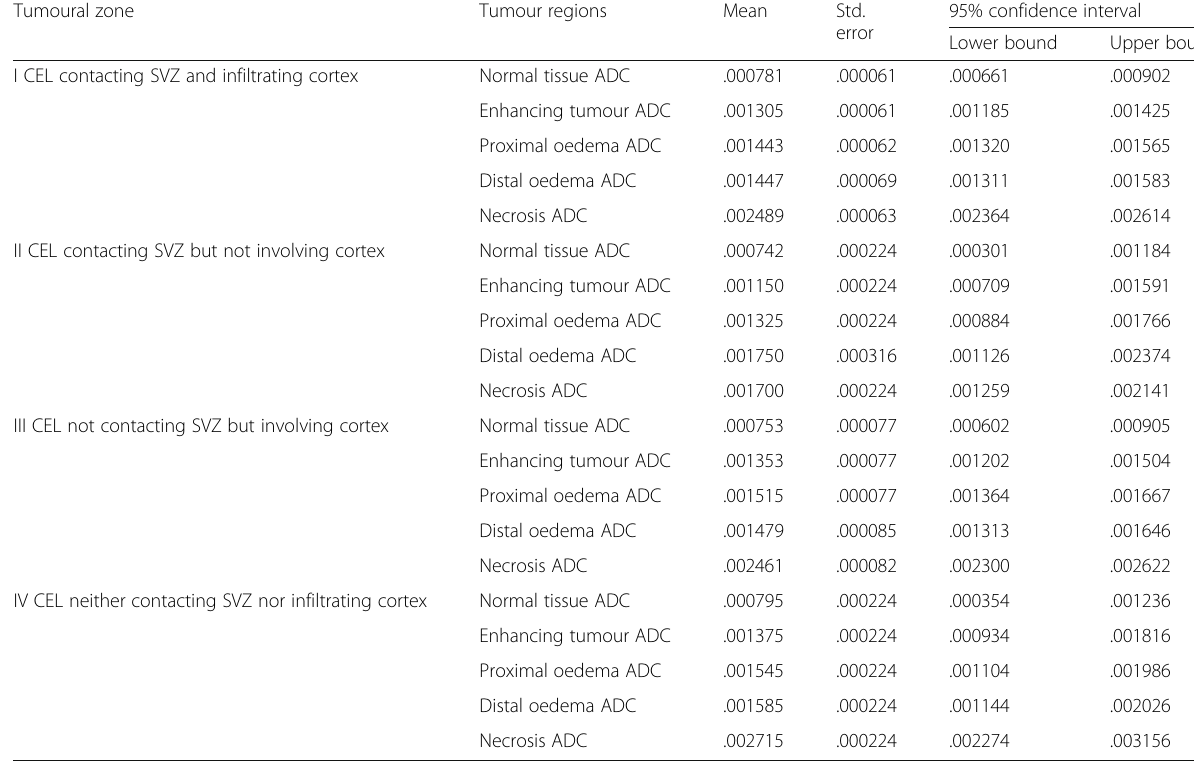
Table 2 Estimated marginal means of ADC values (mm 2 /s) at each tumour regions and subgrouped based on SVZ and cortex involvement (MRI-based classification) Tumoural